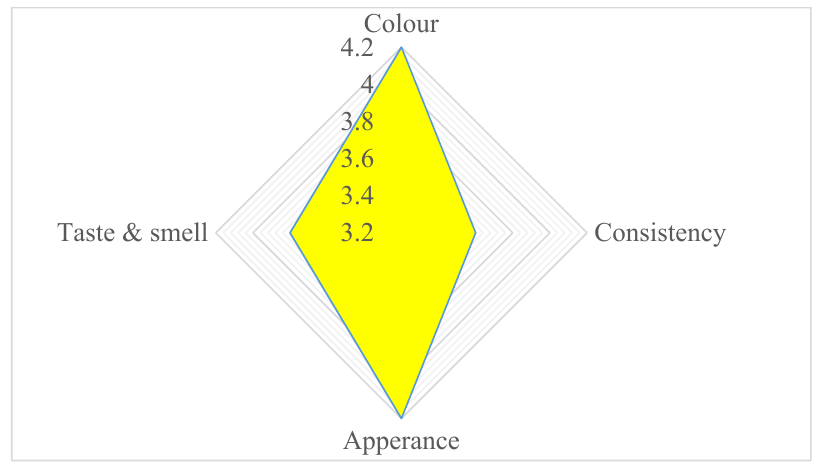
Figure 4. Assessment of major features of French fries (FF) on a 1–5° scale. Table 5. FF quality evaluation and their variability (relative standard deviation (RSD) in %).